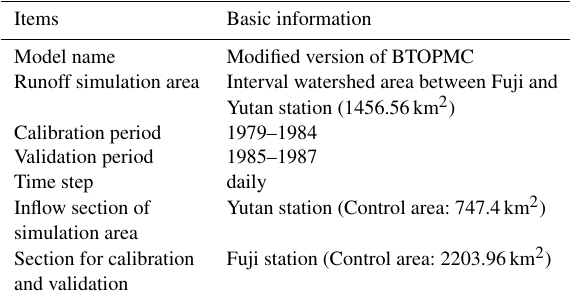
Table 3. Calibration and validation information for BTOPMC model